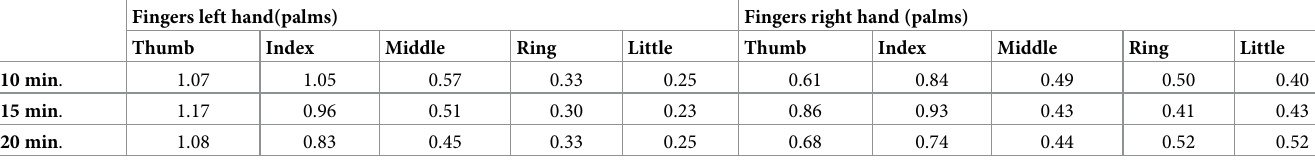
Table 6. Temperature differences (˚C) of the palmar part of the hand. Fingers left hand(palms) Fingers right hand (palms)